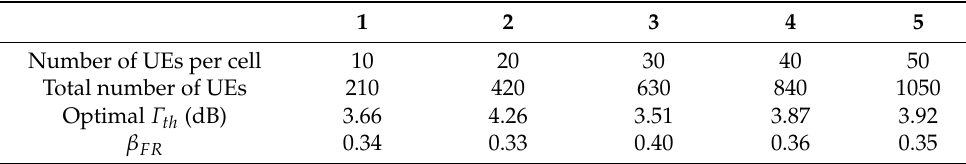
Table 4. ISODATA